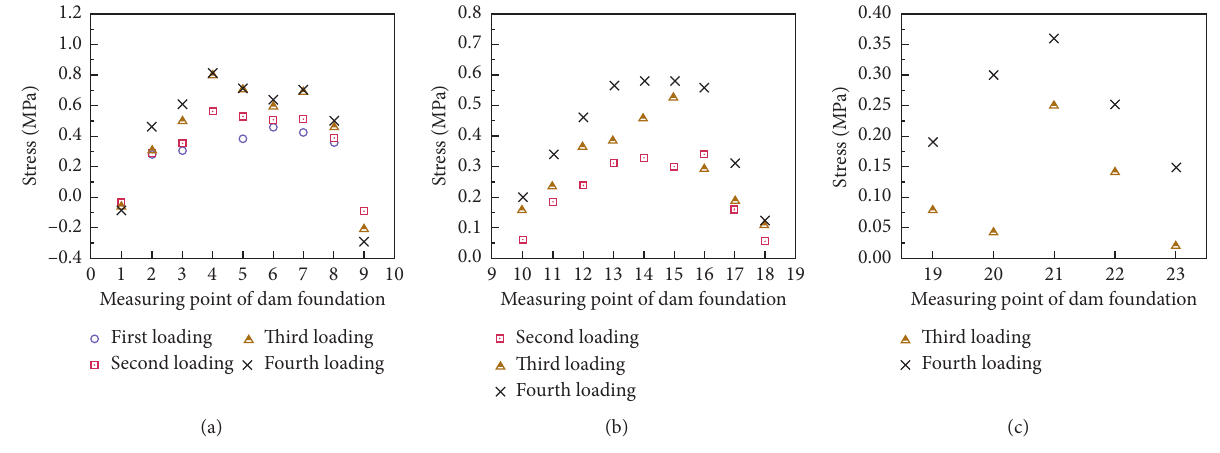
Figure 5: Stress survey map during construction period.